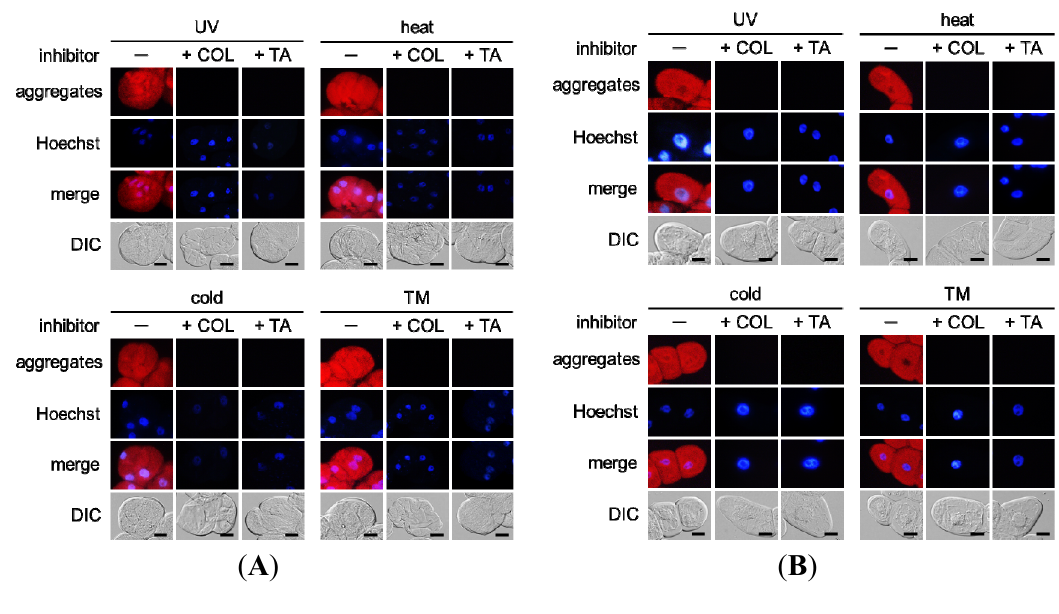
Figure 5. Effect of trichostatin A or colchicine treatment on misfolded protein aggregation in ( A ) grape cultured cells and ( B ) tobacco cultured cells exposed to environmental stresses. Treatment with trichostatin A (TA) or colchicine (COL) completely suppressed misfolded protein aggregation induced by the environmental stresses. The red color and the blue color indicate the fluorescence of detected aggregates and stained nuclei, respectively. TM, tunicamycin; Merge, a merged image; DIC, an image observed under a DIC microscope; Scale bars, 20 μ